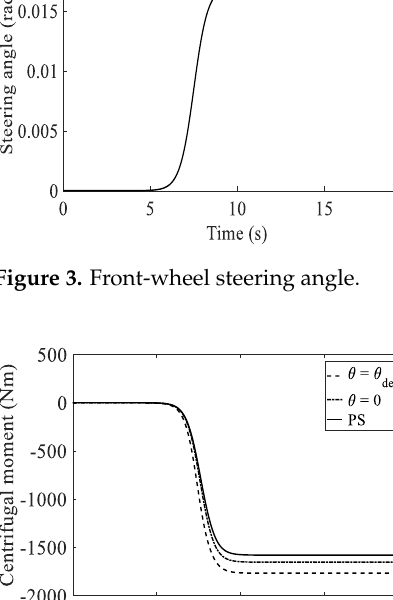
Figure 3. Front-wheel steering angle.